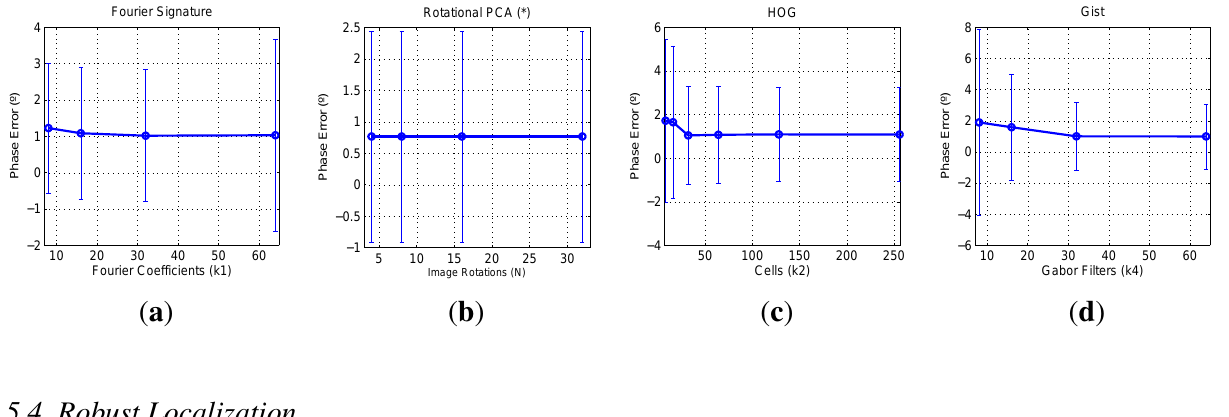
Figure 12. COLD database. Mean orientation error when comparing each test descriptor with its nearest neighbor in the database depending on the parameter of the descriptor ( a ) Fourier Signature; ( b ) rotational PCA; ( c ) HOG and ( d ) gist